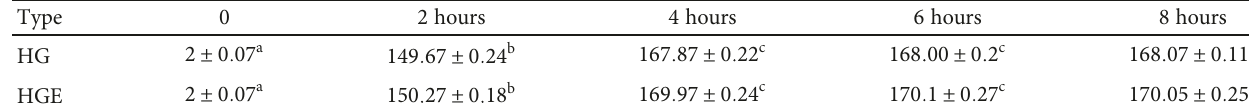
Table 3: Water holding ability of a synthesized prepared hydrogel.